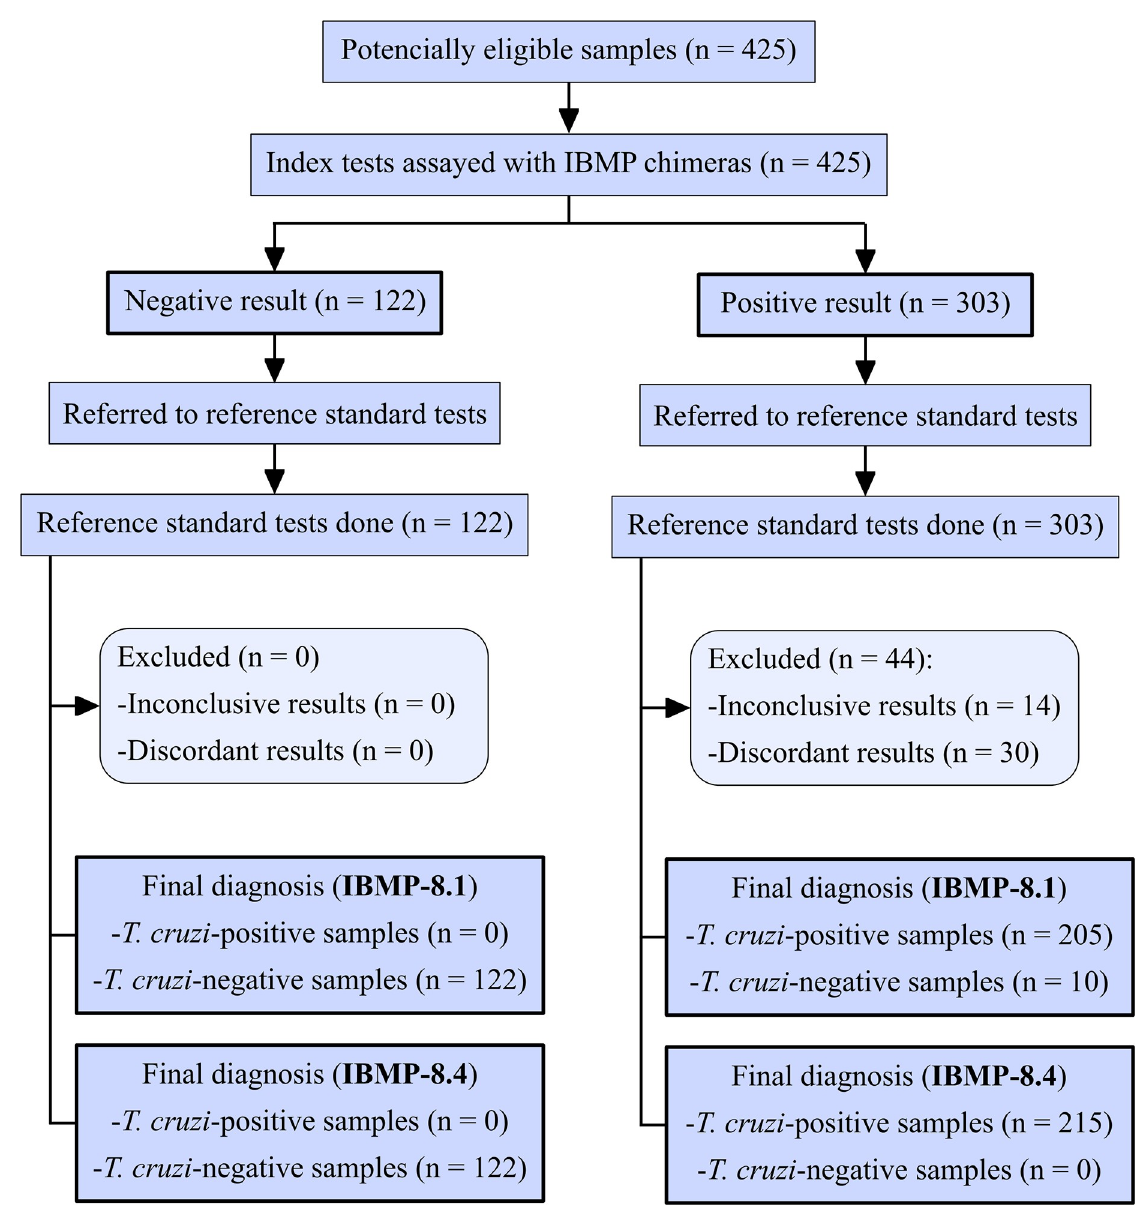
Fig 2. Flowchart depicting study design in conformity with the Standards for Reporting of Diagnostic Accuracy Studies (STARD) guidelines.